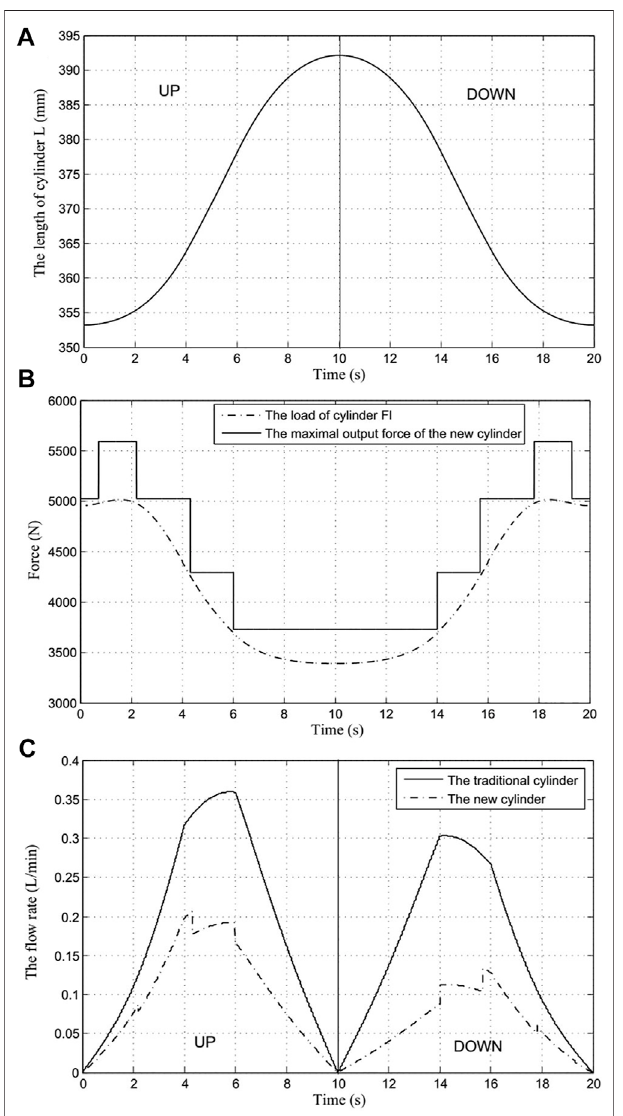
FIGURE 7 | The results of the experiment (A) . Displacement of the cylinder; (B) . Load and matching output force of the proposed actuator; (C) . Flow rate supplied by the hydraulic system.